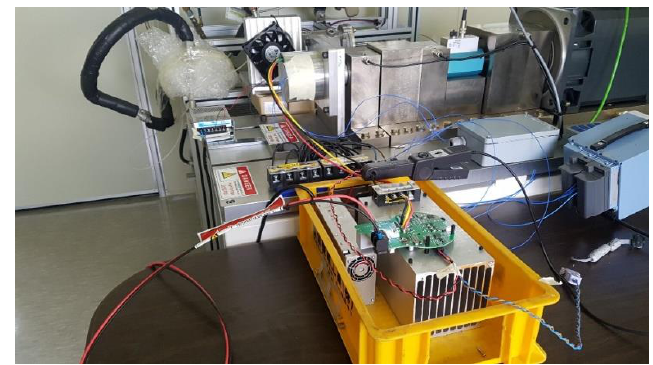
Figure 4. Setup of a voltage source inverter (VSI).